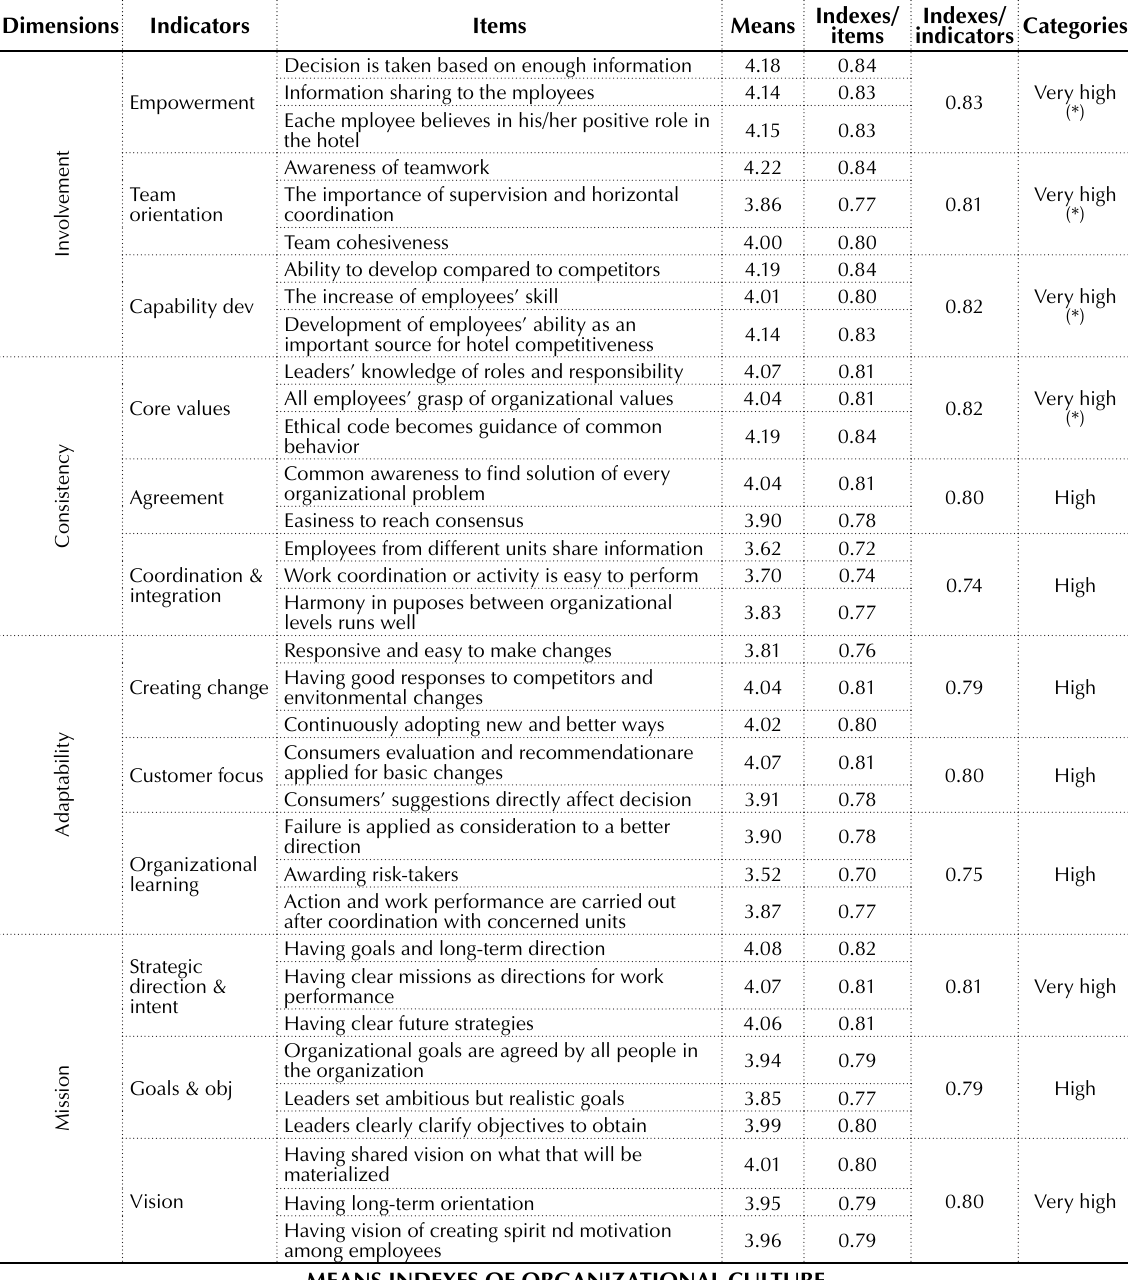
Table 1. The results of organizational culture index calculation Dimensions